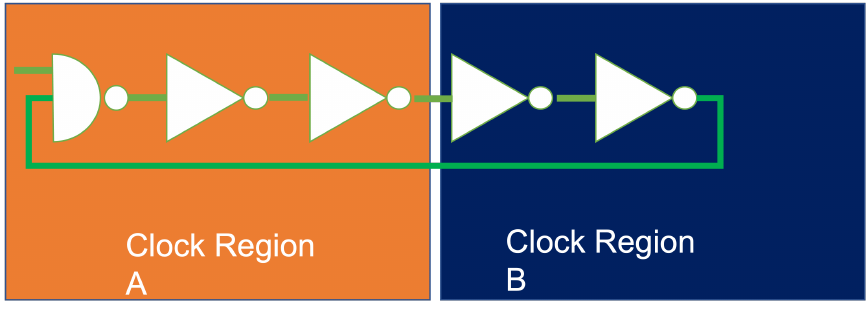
Figure 4. Placing an RO PUF in two different clock